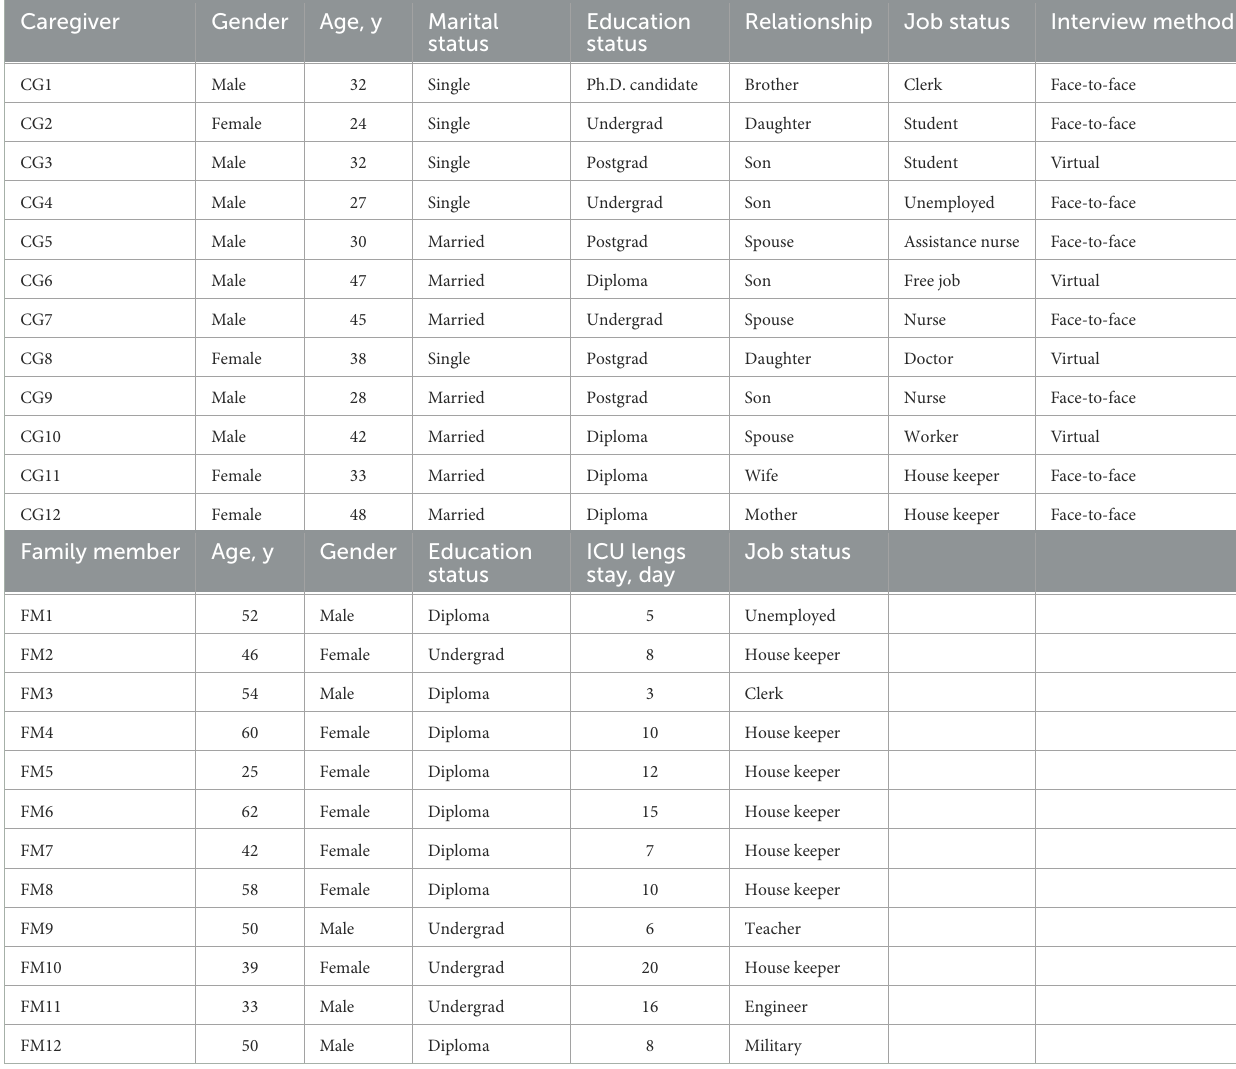
TABLE 1 Characteristics of the family caregivers and their family member.